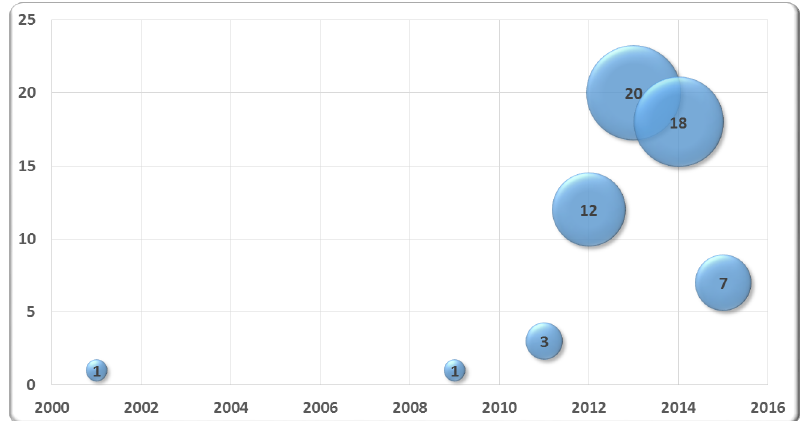
Fig. 2. Year-wise distribution of found